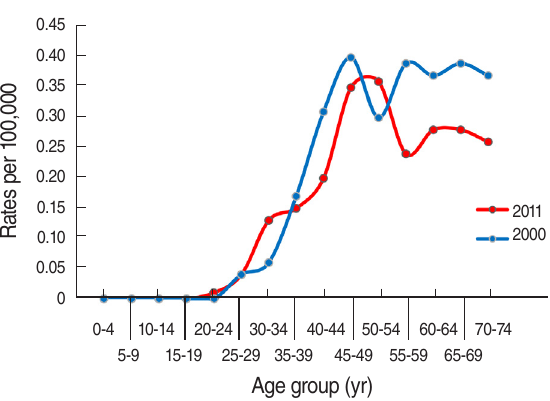
Figure 4. Age-specific mortality rates per 100,000 populations of cervical cancer in Korea, 2000 and 2011. Source from Korean Sta- tistical Information Service. Death causes by 5-year age group and gender, mortality rates (1983-2013); 2014 [13].